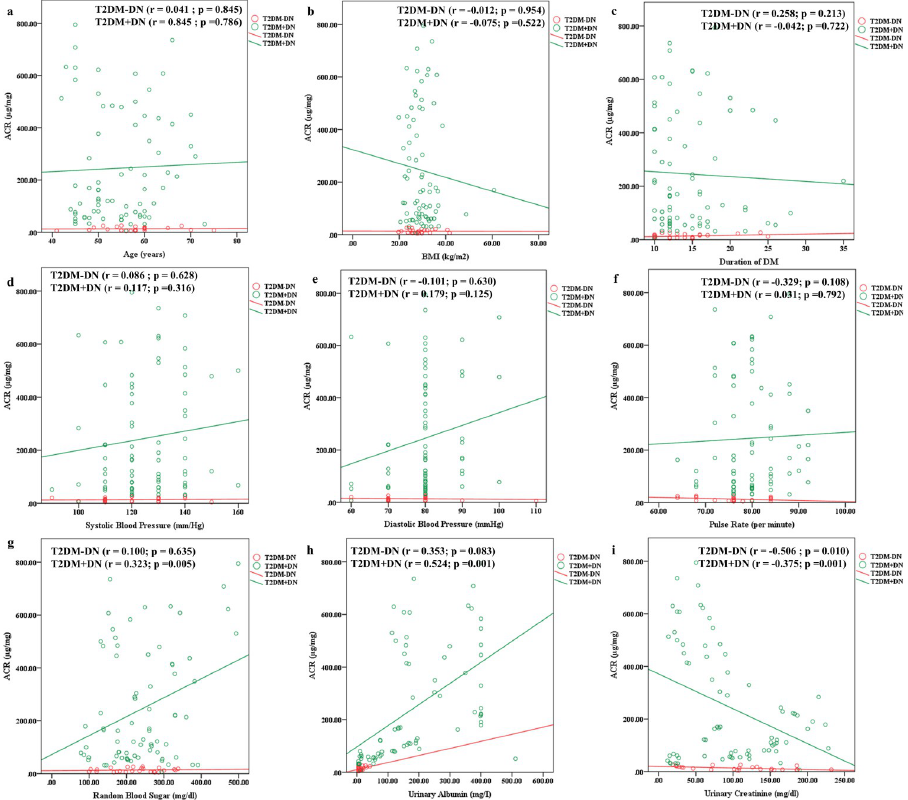
Fig 1. Scatter plots showing Pearson correlation coefficients of ACR with various clinical parameters among type 2 diabetes mellitus patients with or without diabetic nephropathy. Correlation of ACR with a) age b) BMI c) Duration of Diabetes mellitus d) Systolic blood pressure e) Diastolic blood pressure f) pulse rate g) random blood sugar h) urinary albumin excretion i) urinary creatinine.